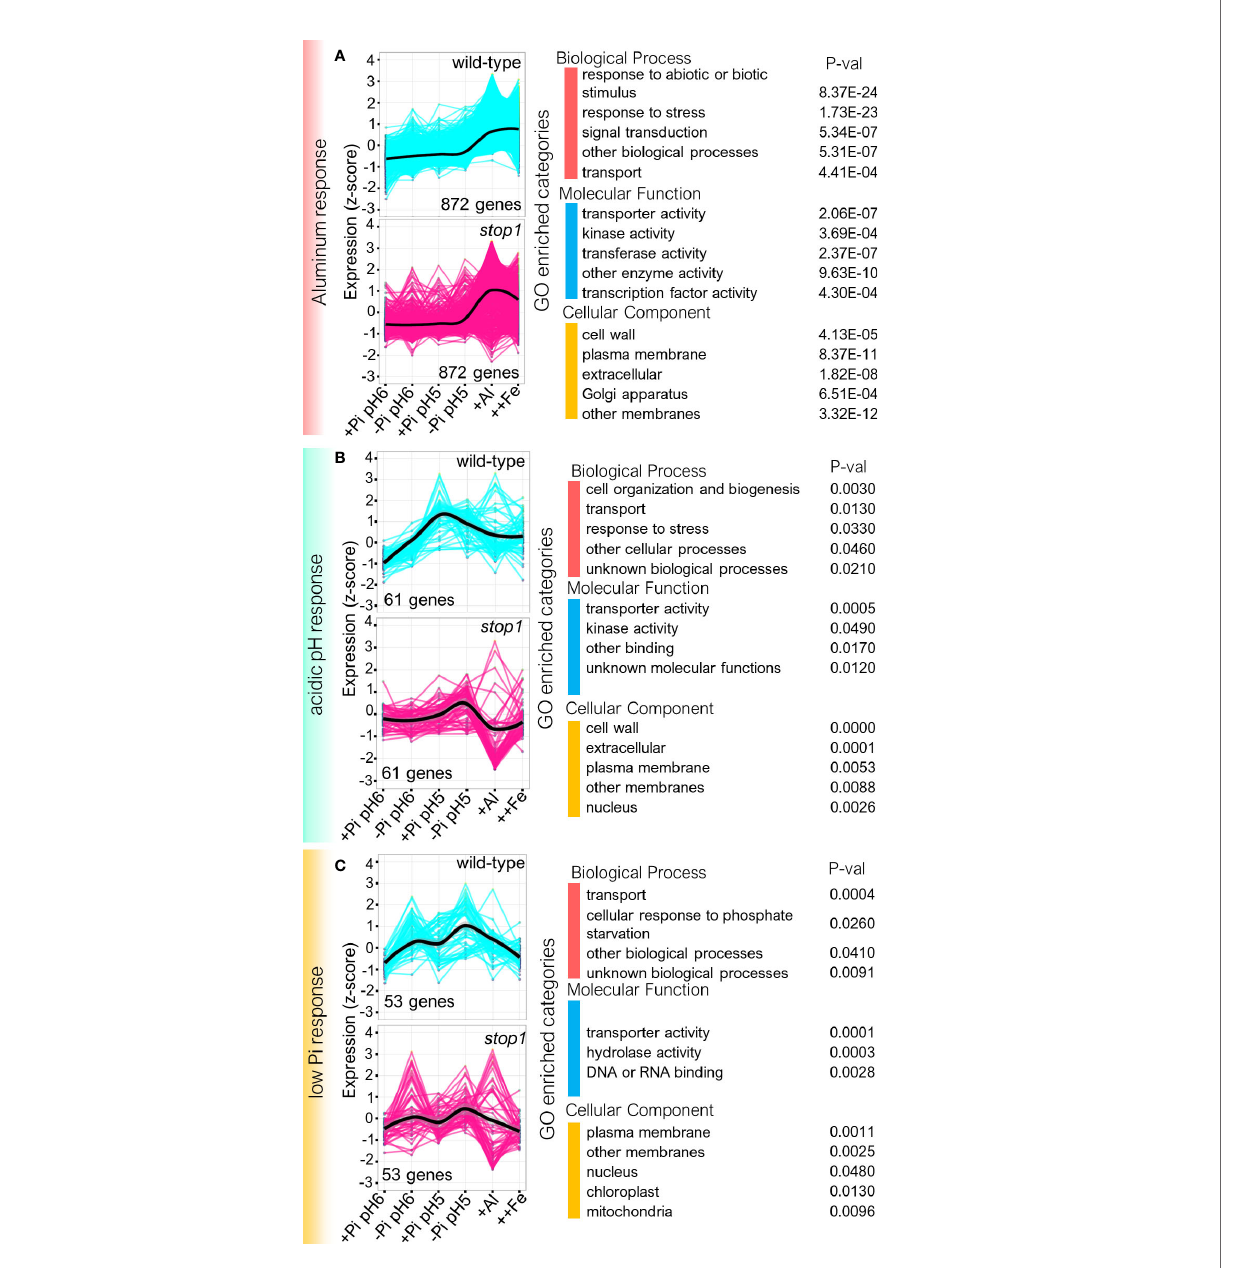
FIGURE 4 | Expression pro fi ling and Gene ontology (GO) analysis of the transcriptionally upregulated processes in the roots of wild-type and stop1 seedlings in response to low Pi, low pH and Al. (A) GO pro fi ling of genes whose expression is signi fi cantly induced in wild-type (FDR < 0.05) in response to Al or to Al and Fe treatment (subsets b + c from Figure 2A ) this gene set is referred to in the text and the fi gure as the Aluminum response . Left: Normalized expression pro fi les (z-score; y-axis) of Aluminum response genes in the roots of wild-type and stop1 seedlings in response to the tested treatments (x-axis). Right: Summary of GO analysis performed using the Classi fi cation SuperViewer with Bootstrap (see Materials and Methods). For the complete analysis including GO categories for each of the classes presented and gene identi fi ers see Supplementary Table 1 . (B) GO pro fi ling of genes whose expression is signi fi cantly induced in wild-type (FDR < 0.05) in response to pH 5 across all treatments (subsets h + i + j + k + q + r from Figure 2A ), this gene set is referred to as the acidic pH response . Left: Normalized expression pro fi les of acidic pH response genes (z-score; y-axis) in the roots of wild-type and stop1 seedlings in response to the tested treatments (x-axis). Right: Summary of GO analysis performed using the Classi fi cation SuperViewer with Bootstrap (see Materials and Methods). For the complete analysis including GO categories for each of the classes presented and gene identi fi ers see Supplementary Table 1 . (C) GO pro fi ling of genes whose expression is induced in low Pi across all treatments (subsets e + l + n + o + t from Figure 2A ), this gene set is referred to in the text as low Pi response . Left: Normalized gene expression pro fi les of low Pi response (z-score; y-axis) in the roots of wild- type and stop1 seedlings in response to the tested treatments (x-axis). Right: Summary of GO analysis performed using the Classi fi cation SuperViewer with Bootstrap (see Materials and Methods). Signi fi cantly enriched GO processes have a P-value <0.05. For the complete analysis including GO categories and gene identi fi ers see Supplementary Table 1